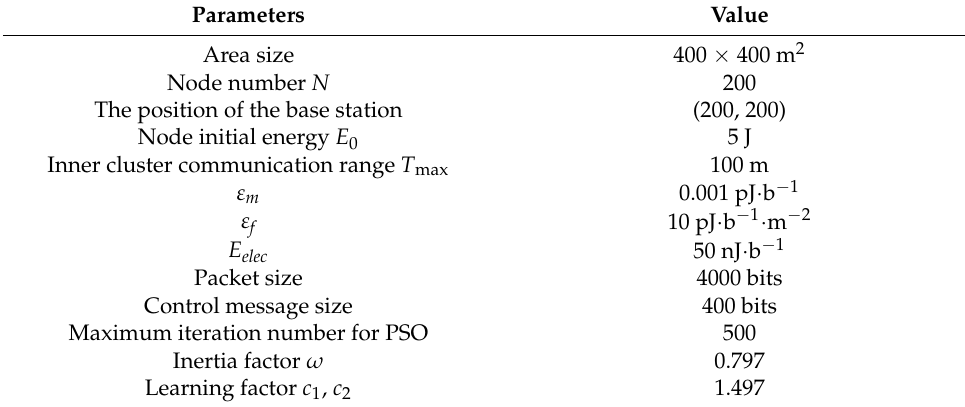
Table 1. Parameter settings in the